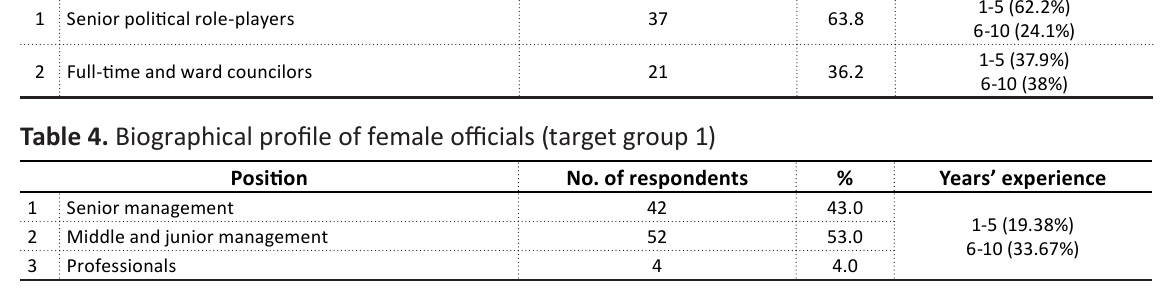
Table 5. Biographical profile of the reference group (target group 2)